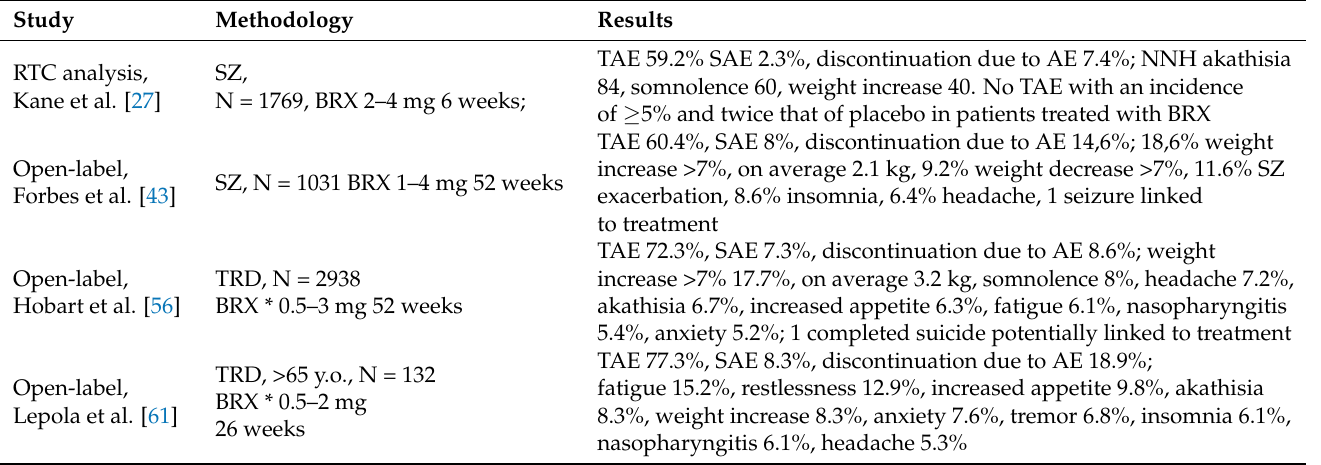
Table 6. The studies on brexipiprazole treatment safety and